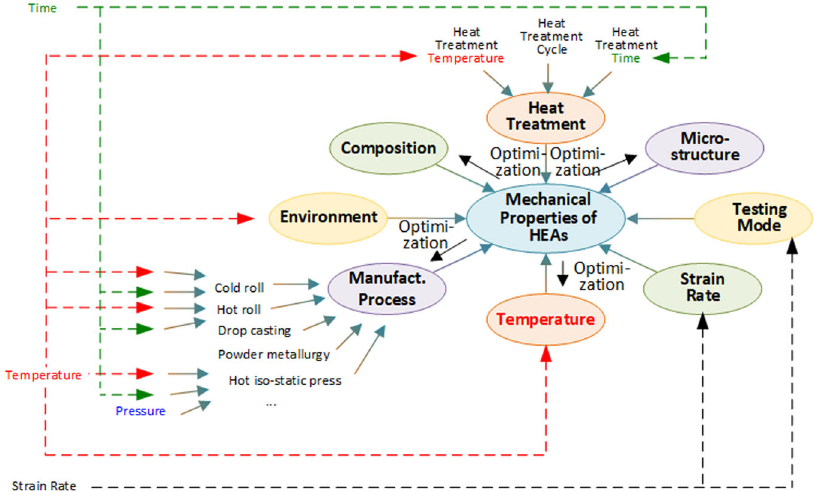
Fig. 1 High-level depiction of role of optimization techniques for inferring the features of HEAs, including the composition, microstructure, heat treatment, and process, from mechanical properties, including ultimate strength, desired. The color coding provides the insight into the extent to which the sources are separate, and yet interconnected to a certain extent 34,35